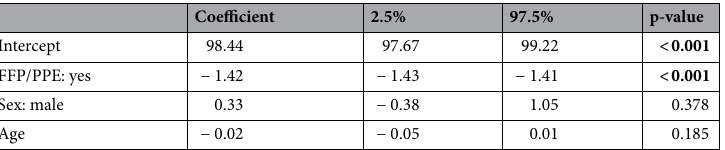
Table 2. The model showed the influence of working in the FFP3/PPE for the SpO2, taking into consideration both age and gender. In such cases, our model has the following form: SpO2[%] ~ working in FFP3/ PPE + Sex + Age + (Time/Person). Significant values are bold.